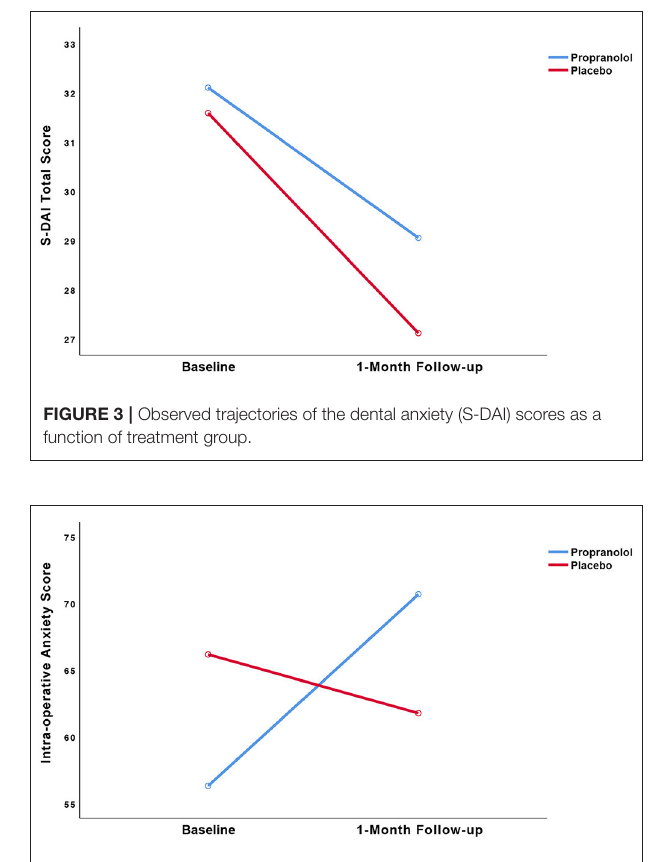
FIGURE 4 | Observed trajectories of the intra-operative state anxiety score as a function of treatment group.